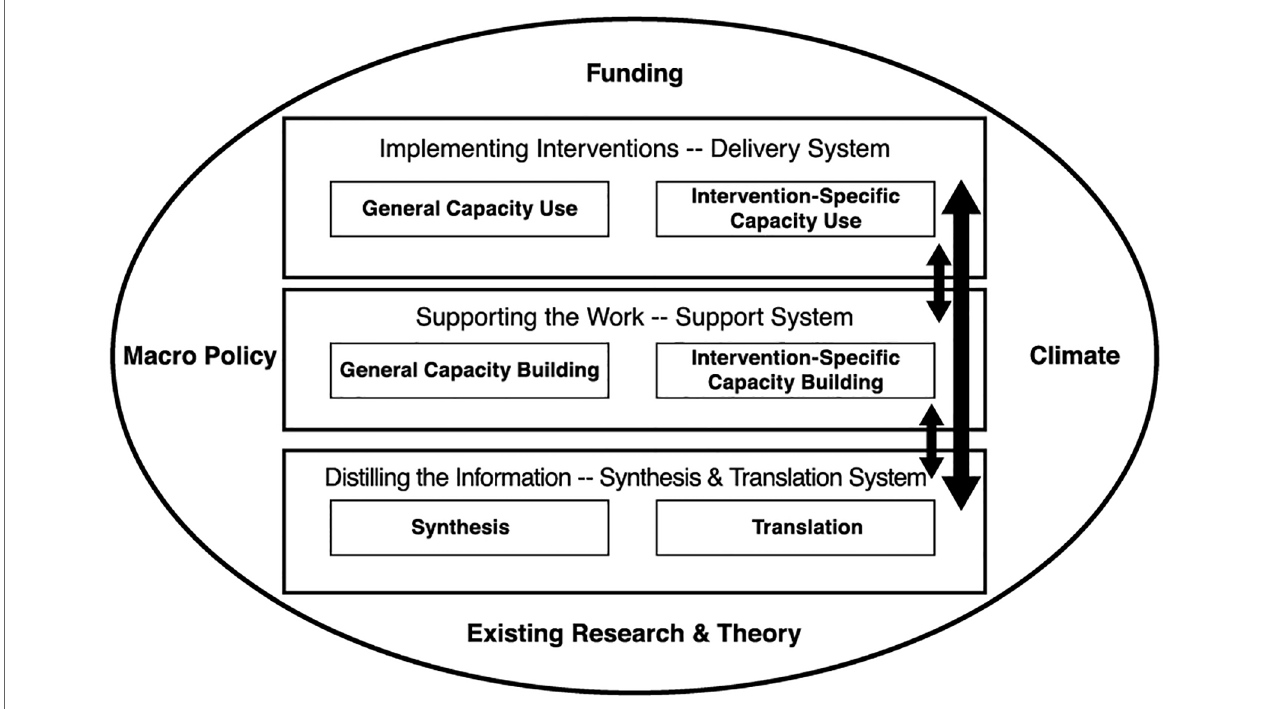
FIGURE 1 | The Interactive Systems Framework